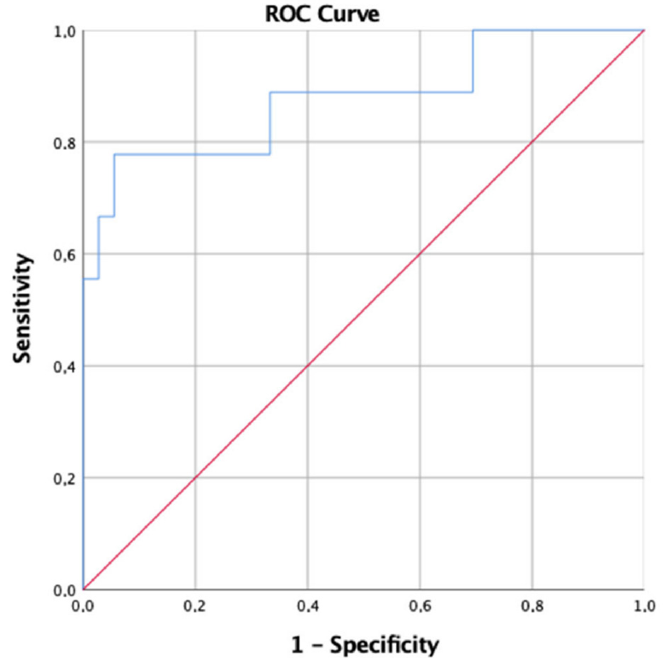
Figure 2. Receiver operating characteristic (ROC) curve comparing accuracy of D(A-a)O 2 at first BGA in relation to the prediction of severe pneumonia. Area under the curve (AUC): 0.877 (95% CI: